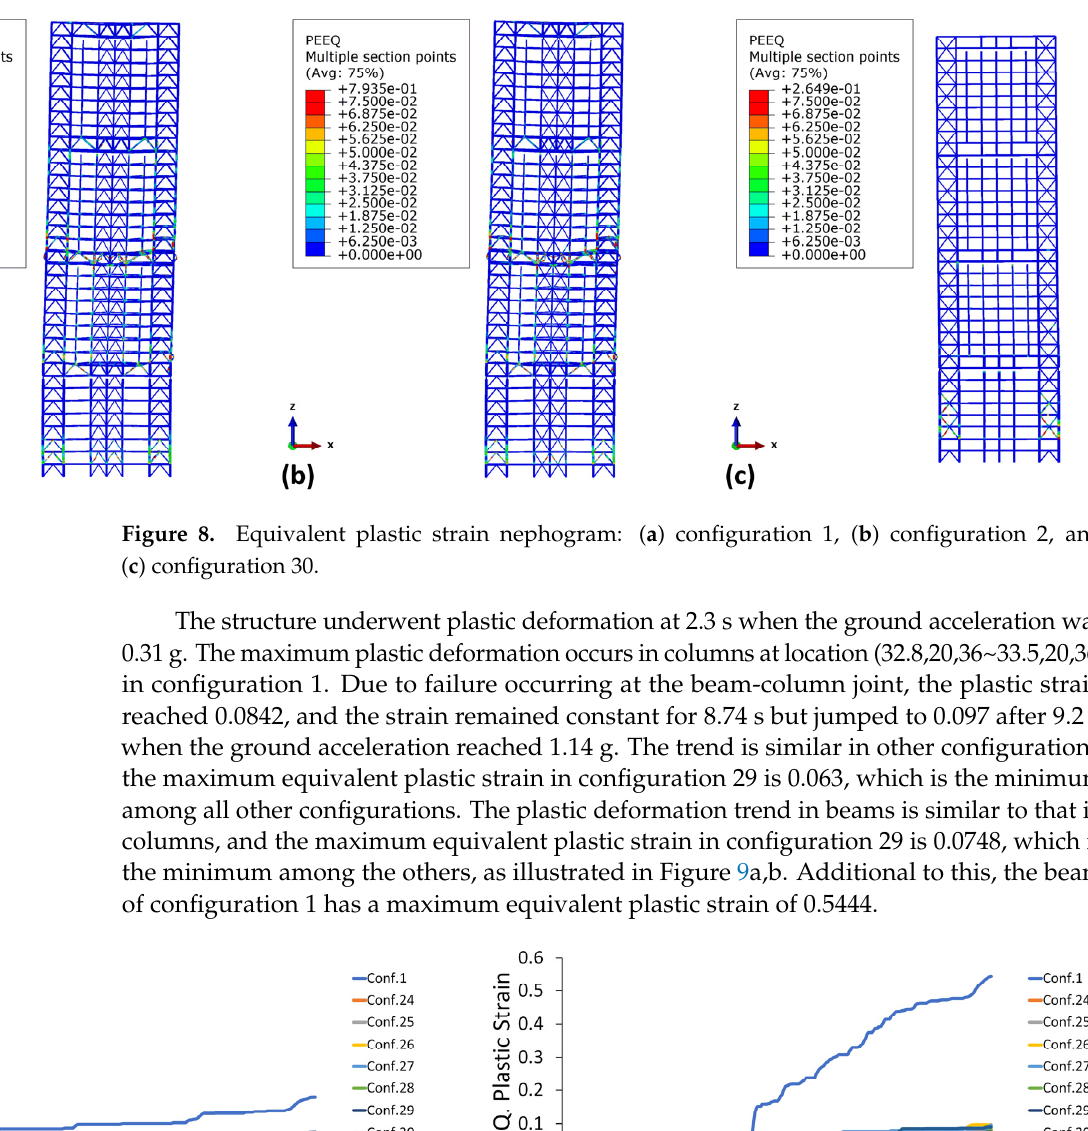
Figure 10. Energy dissipation in different configurations under the Nahanni earthquake: ( a ) plastic dissipation and ( b ) viscous dissipation. 5.4. Peak Transient Story Drift Peak transient story drift is one of the most important indicators of structural re ‐ sponse. Different configurations, which have less than 0.2 m settlement at the top of the structure along with an equivalent plastic strain less than 0.1 in beams and columns, are selected in this section for a comparative study. The mega ‐ frame of configuration 1, which is the base case, passed the limits of its structural response at a 40 m height, until 60 m, and showed the maximum drift at 80 m, which is 0.0399. The entire structure above the second mega ‐ beam tilted to the right because of catastrophic plastic deformation at mega ‐ beams 1 and 2 of configuration 1, causing peak transient story drift to exceed the safety limits. The equivalent plastic strain nephogram for configuration 1, Figure 8a, confirms the reason for exceeding limits. Other configurations did not go beyond the structural limits, as shown in Figure 11. In the peak transient story drift in the mega ‐ frame, zero drift